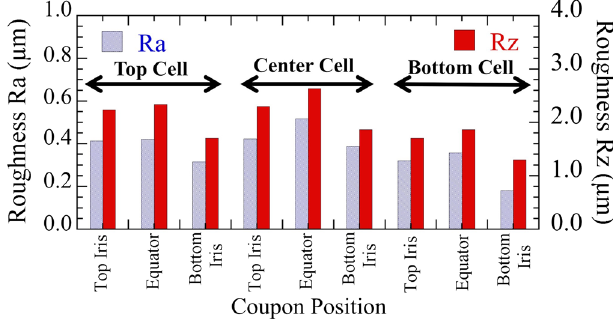
°C.FIG. 21. Roughness Ra and Rz of the nine coupon surfaces after the VEP performed for an average removal thickness of ∼ 25 μ